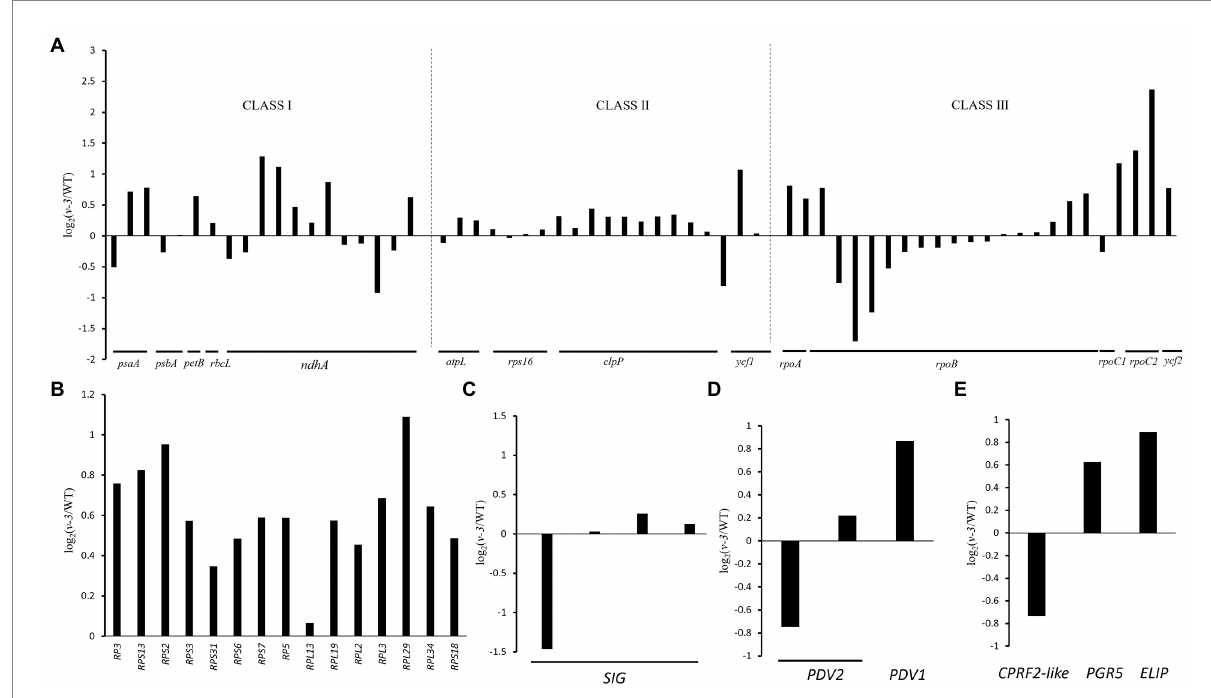
FIGURE 8 Transcriptional changes of chloroplast-related genes between the WT and v-3 based on RNA-Seq data. (A) Levels of gene expression controlled by different polymerases, Class I: PEP, Class II: PEP and NEP, and Class III: NEP. (B) The levels of expression of rRNAs in the WT and v-3. (C) The levels of expression of SIG in the WT and v-3. (D) The levels of expression of PDV1 and PDV2 in the WT and v-3 . (E) The levels of expression of CPRF2- like , PGR5 , and ELIP in the WT and v-3 . NEP, nuclear-encoded RNA polymerase; PEP, plastid RNA polymerase; CPRF2, common plant regulatory factor 2; PGR5, Proton gradient regulation; ELIP, Early light-induced protein; WT, wild